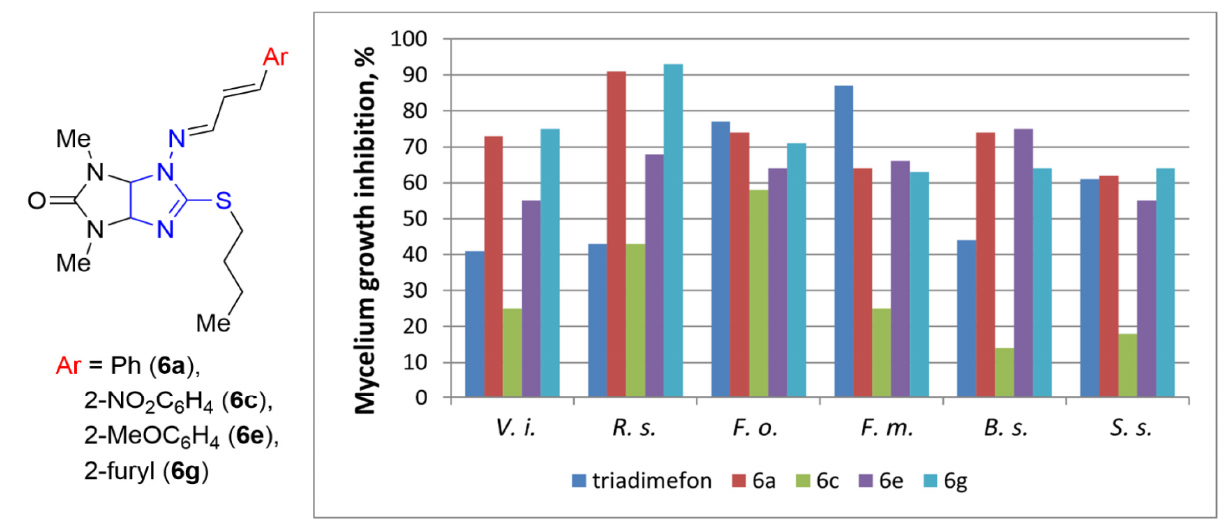
Figure 3. Venturia inaequalis ( V. i .), Rhizoctonia solani ( R. s .), Fusarium oxysporum ( F. o .), Fusarium